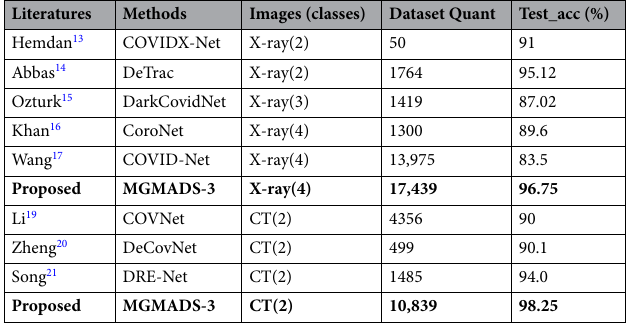
Table 4. Model performance comparison. Bold values indicate better results than other